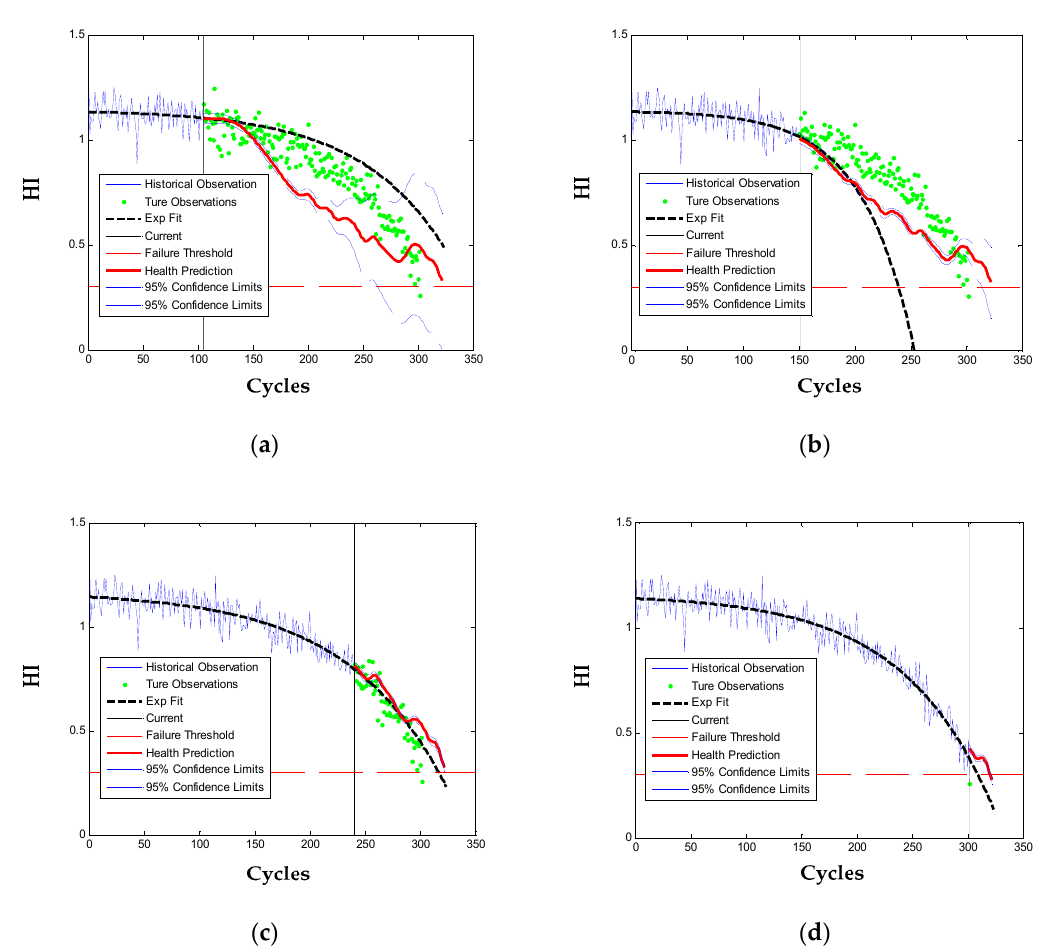
Figure 9. HI prediction for the testing engine # 49 at four percentages of the observations: ( a ) 35%; ( b ) 50%; ( c ) 80%; ( d ) 100%.